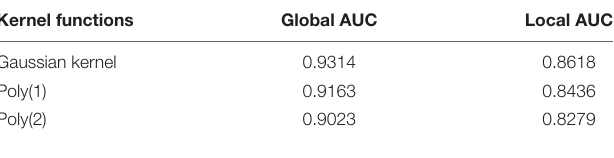
TABLE 1 | Comparison of global AUC and local AUC between different kernel functions used in KRR under LOOCV. Kernel functions